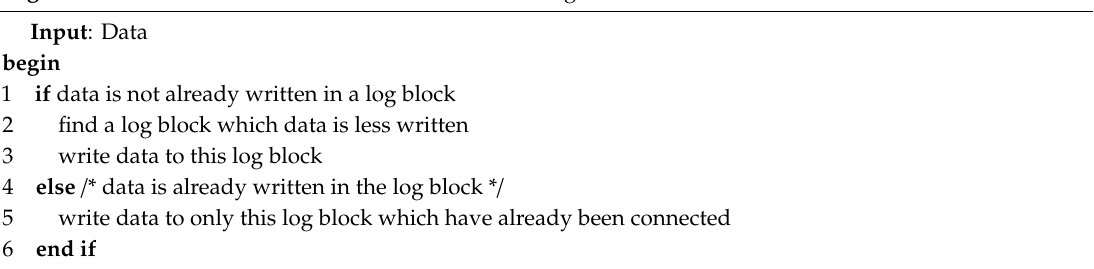
Algorithm 2: When data in a data block is written to a log